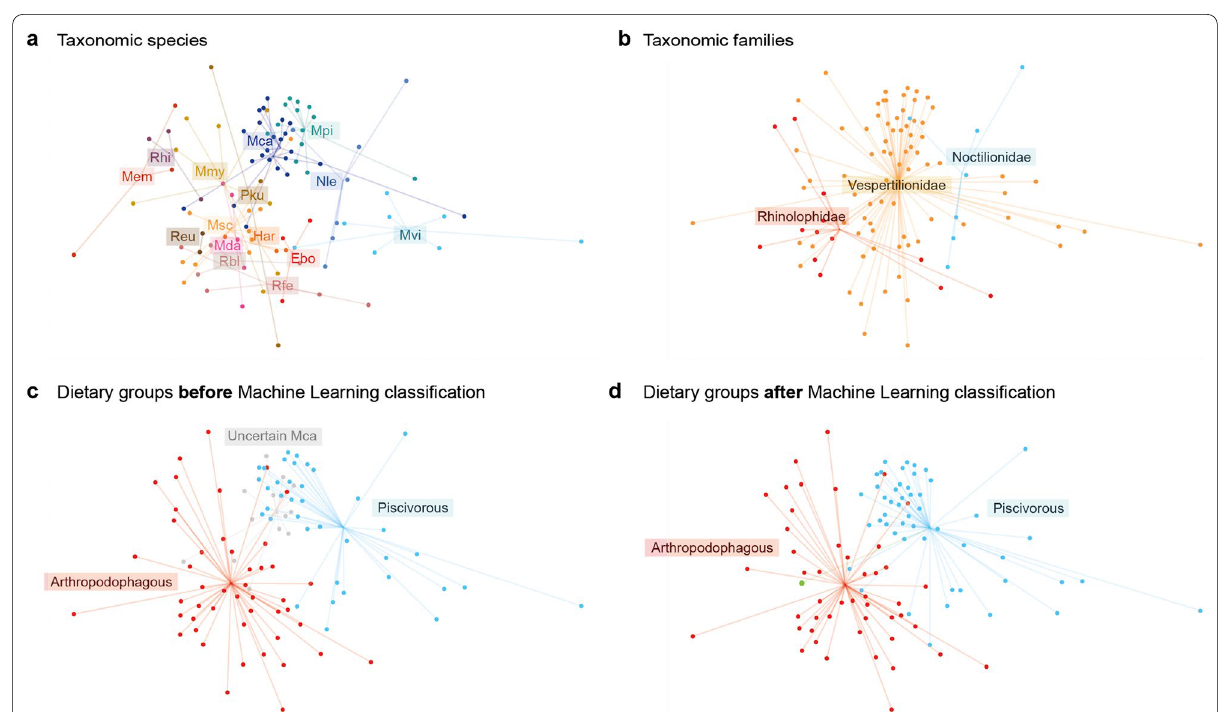
Fig. 3 Ordination of the gut microbial communities of the analysed bats. a Samples coloured by host species. b Samples coloured by taxonomic families. c Samples coloured according to the dietary groups set before the machine learning classification. Grey dots represent Myotis capaccinii individuals from colonies in which no piscivory has been reported. These samples were excluded from the machine learning model training process. d Samples coloured according to the dietary groups predicted by the machine learning classification. The green dot is the only M. capaccinii that was classified as an arthropodophage. The bat species abbreviations are Ebo Eptesicus bottae , Har Hypsugo ariel , = = Msc Miniopterus schreibersii , Mca Myotis capaccinii , Mda M. daubentonii , Mem M. emarginatus , Mmy M. myotis , Mpi M. pilosus , Mvi M. = = = = = = = vivesi , Nle Noctilio leporinus , Pku Pipistrellus kuhlii , Rbl Rhinolophus blasii , Reu R. euryale , Rhi R. hipposideros , Rfe R. = = = = = =